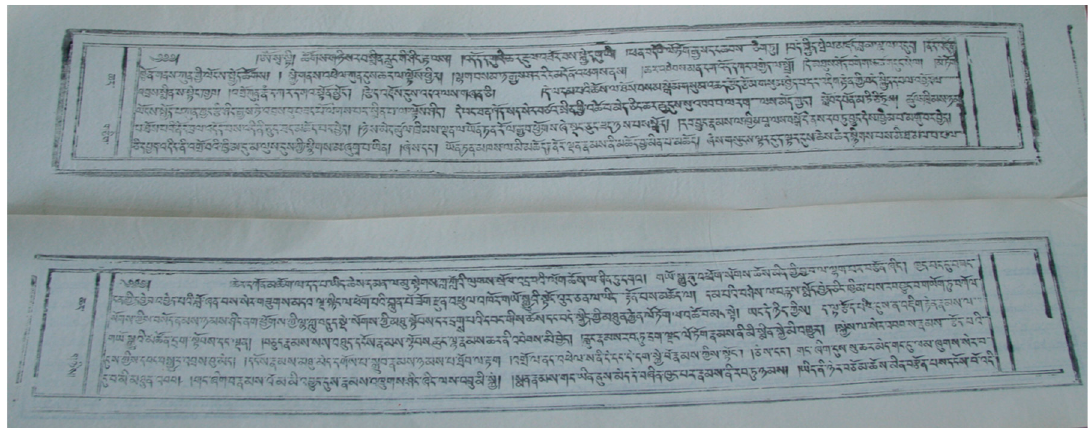
Figure 2. The beginning folios of Sumpa Khenpo’s weather ritual manual. Copies preserved in the Inner Mongolian Academy of Social Sciences at Höhhot, Inner Mongolia, China (© Hanung Kim).